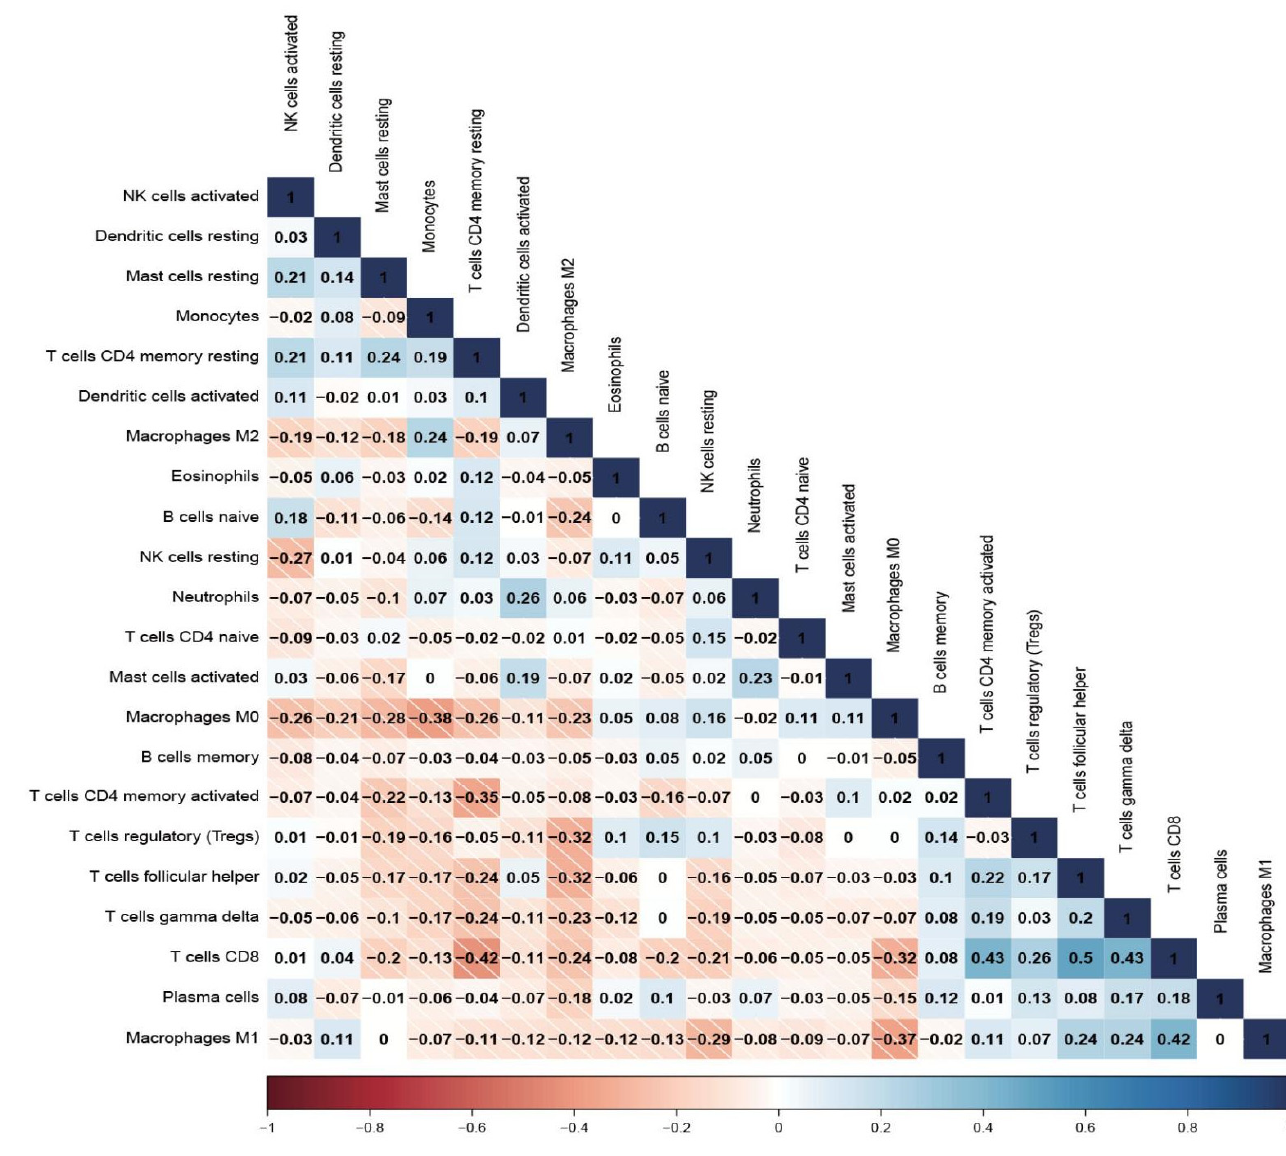
Figure 6. The correlation between different immune cells.